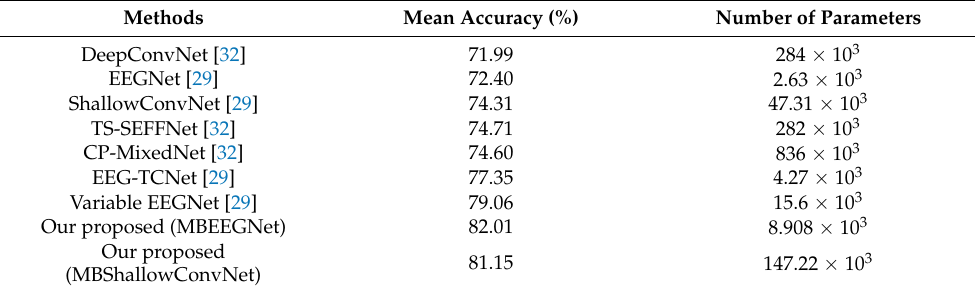
Table 7. Comparison of the number of parameters and mean